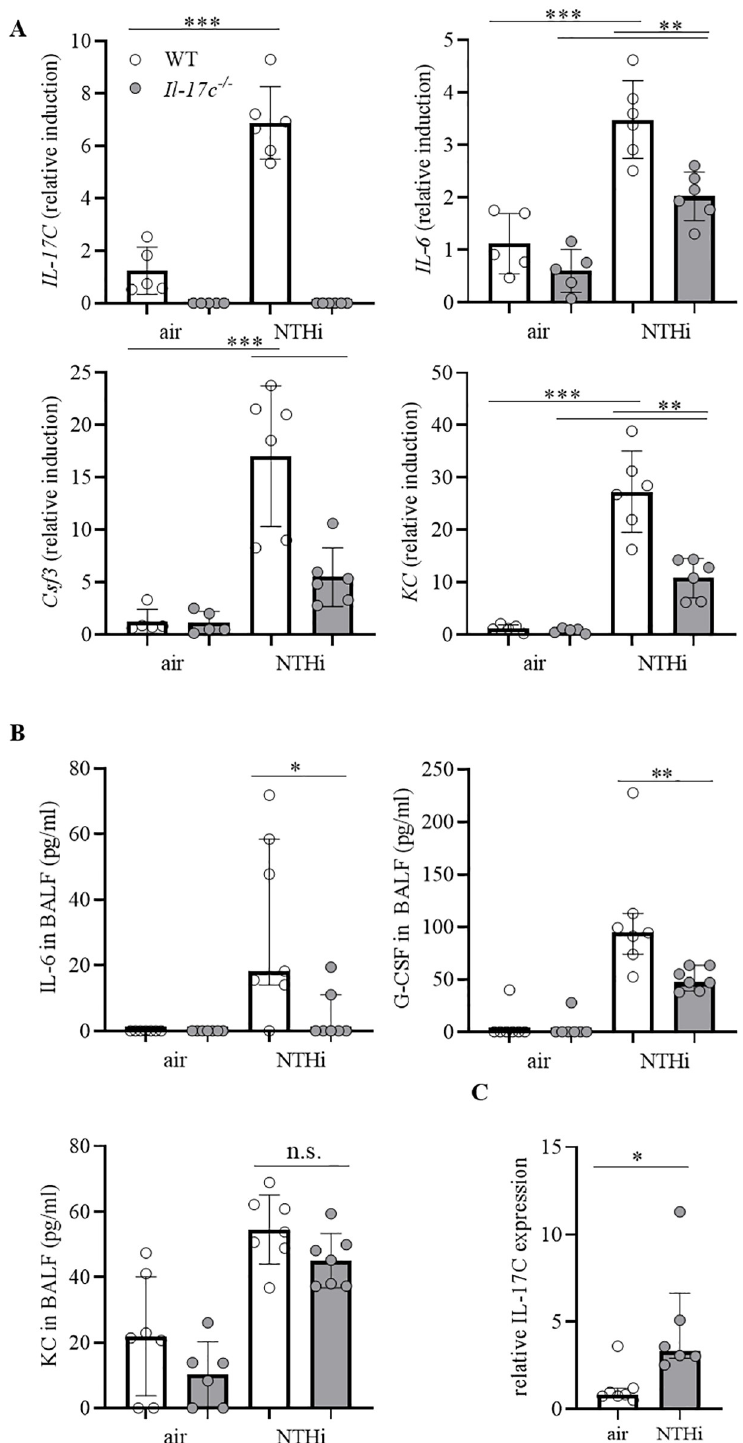
Fig 3. Il-17c deletion decreases the expression of inflammatory cytokines. WT and Il-17c -/ - mice were exposed to heat-inactivated NTHi three times a week (day 1, 3, 5) for 4 weeks. Mice were analyzed 24 hours after the final exposure to NTHi. (A) Relative expression of IL-17C, IL-6, G-CSF, and KC in lung tissue (n = 5–6 mice per group). Data were compared by One-way ANOVA with Bonferroni post-test and are shown as the mean ± SD. �� p < 0.01, and ��� p < 0.001. (B) Concentrations of IL-6, G-CSF, and KC in BAL fluids (n = 4–7 mice per group). (C) Polarized